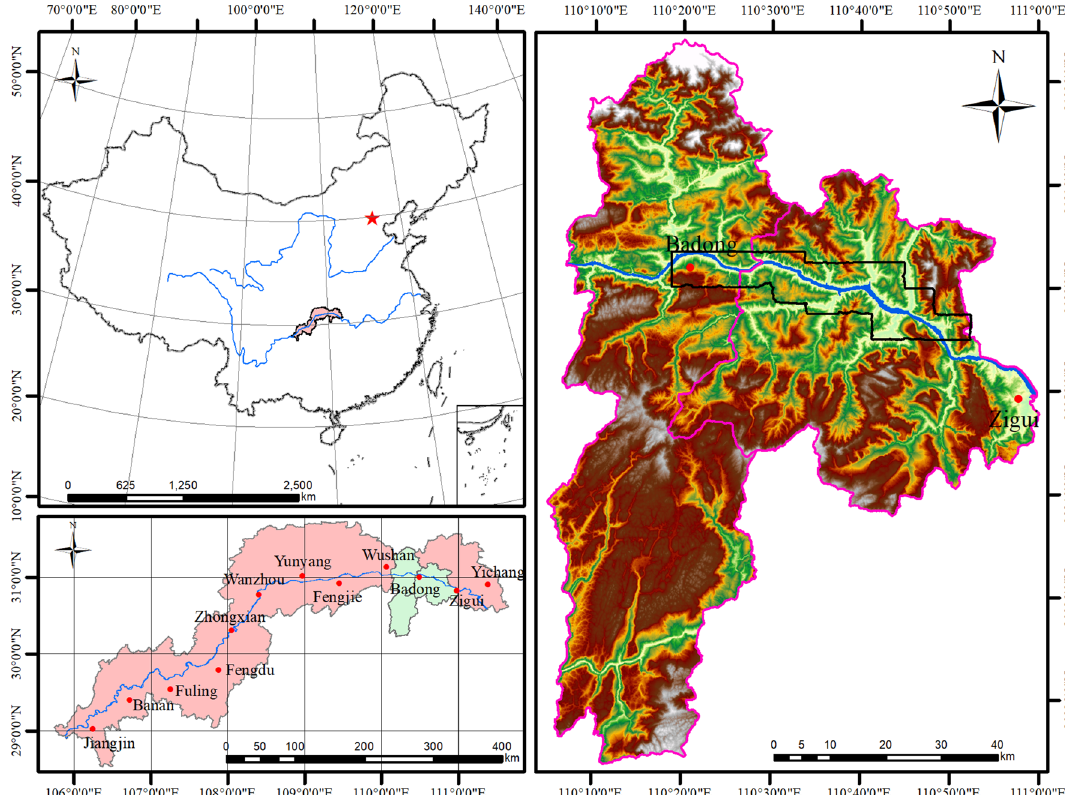
Figure 2. The location of the study area (Drawn with ArcGIS 10.8 software, and the URL is: https:// www. esri. com/ en- us/ arcgis/ about- arcgis/ overv